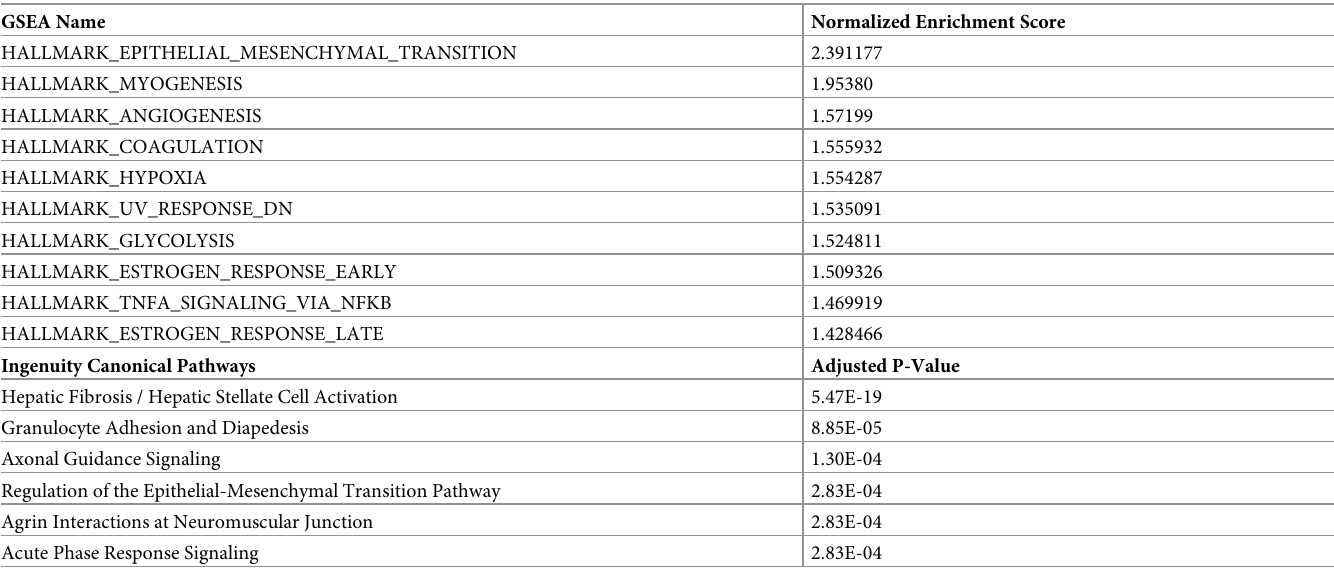
Table 1. Pathway analysis of genes overexpressed in